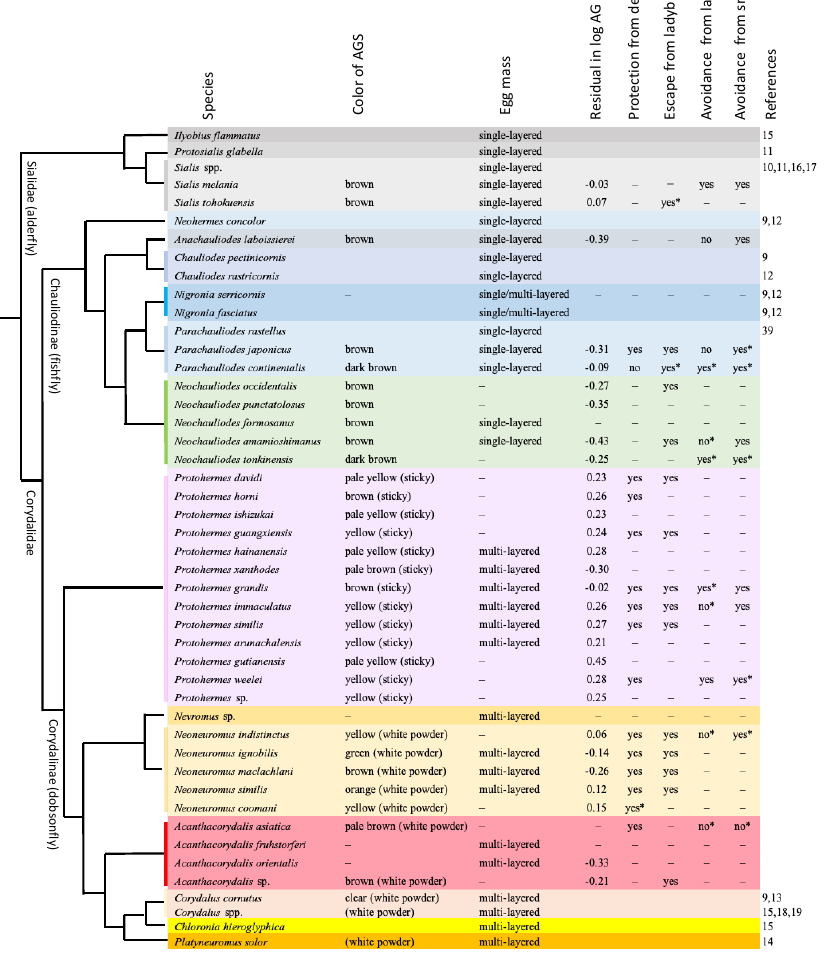
Figure 6. Characteristics of the egg mass and female accessory gland substances (AGS) mapped on the phylogeny of Megaloptera [37]. Different background colors show different genera. * Not statistically significant; – Not examined in this study. For explanation of the log ‐ scale residual of accessory gland (AG) weight, see the statistics section in the main text. With the exception of Nigronia , the multi ‐ layered egg masses were all semispherical in shape (see Figure 2).